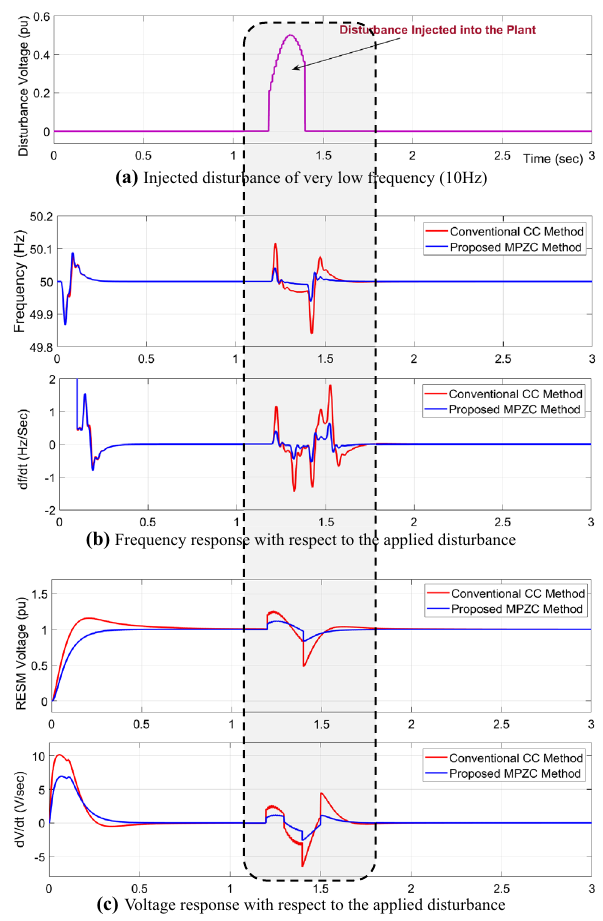
Fig. 14 Voltage and frequency responses during disturbance as per test